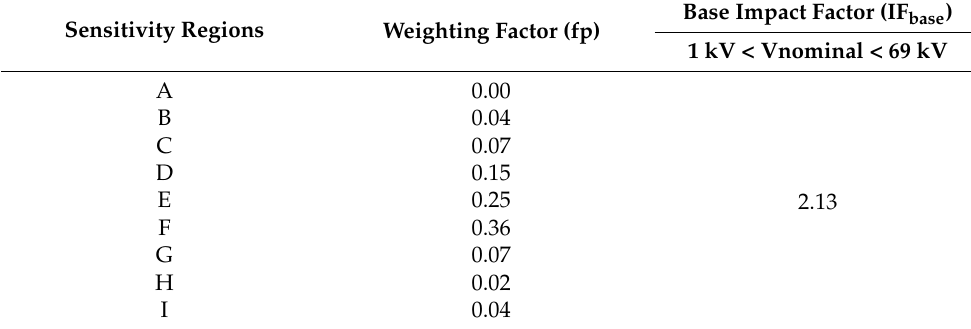
Table 3. Weighting factors and base impact factor